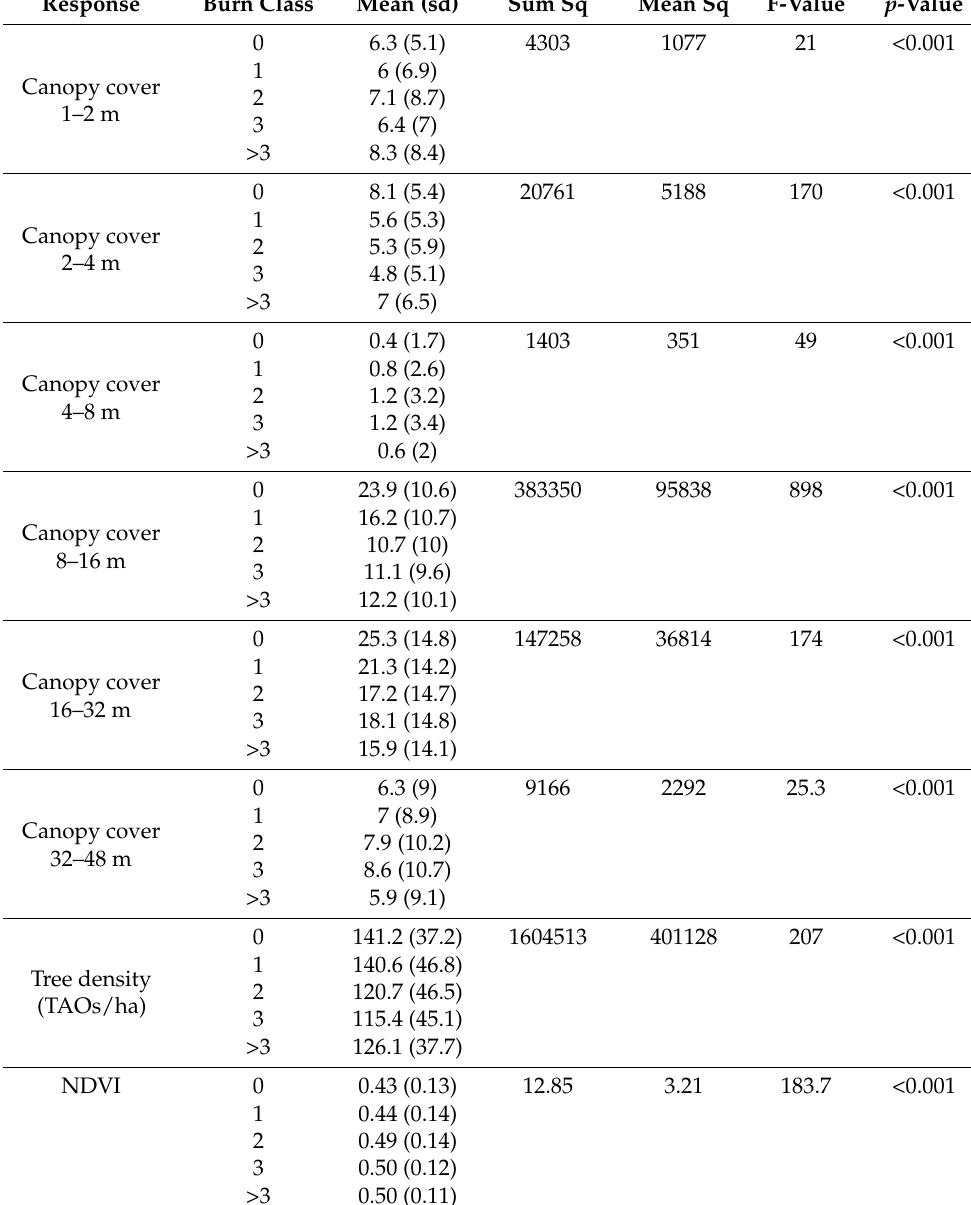
Table 3. Mean (standard deviation) canopy cover by height strata, tree density, and normalized difference vegetation index (NDVI) from samples differing in burn class. One-way analysis of variance results testing differences in means for each response variable according to burn class (df = 4). Pairwise differences were assessed with Tukey HSD tests and are shown in Figures 2–4.